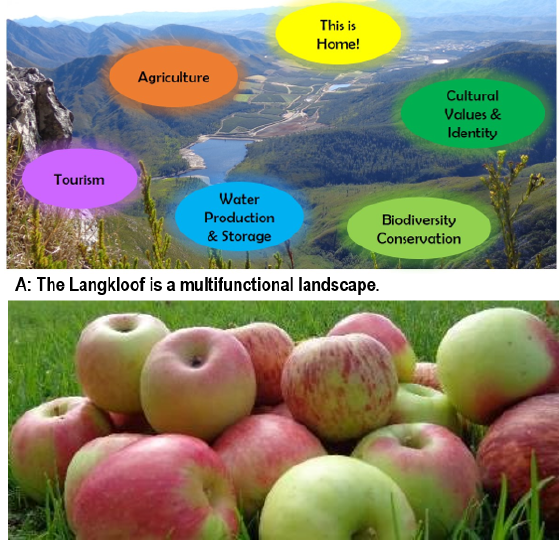
stock farmers (see vignette 3, Table